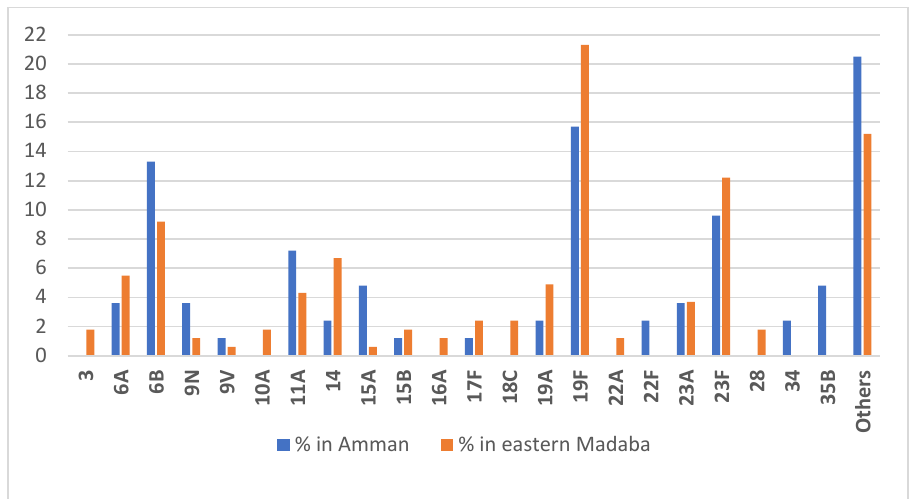
Figure 1. Serotype distribution of isolates from Amman and eastern Madaba. Coverage rates of the pneumococcal isolates in both areas are presented in Table 4. Coverage rates for PCV7, PCV10, PCV13, and the future PCV20 were 42.2%, 42.2%, 48.2%, and 60.2% for Amman, respectively. Significantly higher coverage was detected for PCV13 ( p value = 0.041) and PCV20 ( p value = 0.043) vaccines in the eastern area of Madaba, with rates of coverage of PCV7 (50%), PCV10 (50%), PCV13 (62.2%), and the future PCV20 (73.2%). Table 4. Coverage of Streptococcus pneumoniae to pneumococcal conjugate vaccines. Coverage in Amman and Eastern Madaba